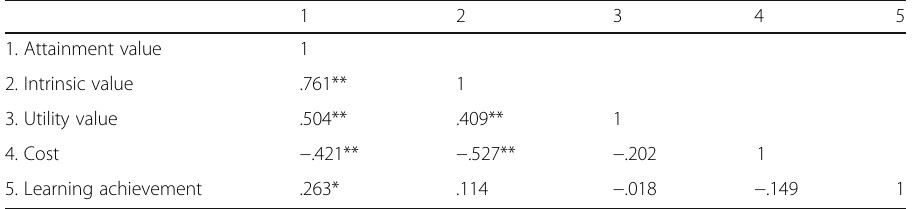
Table 5 Relationship between learning achievement and academic motivation 1